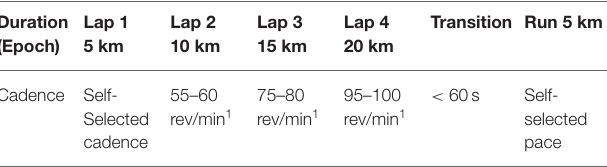
TABLE 1 | Cadence (in rev/min 1 ) and running protocol performed for Experiment 1 and Experiment